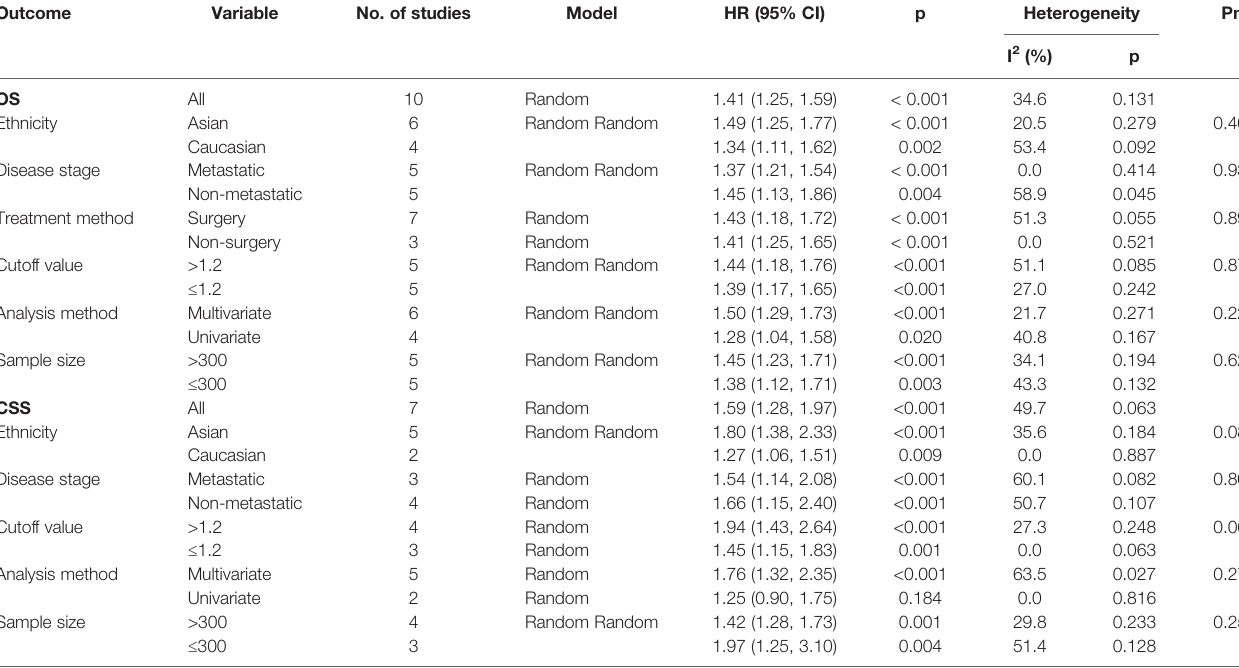
Frontiers in Oncology |